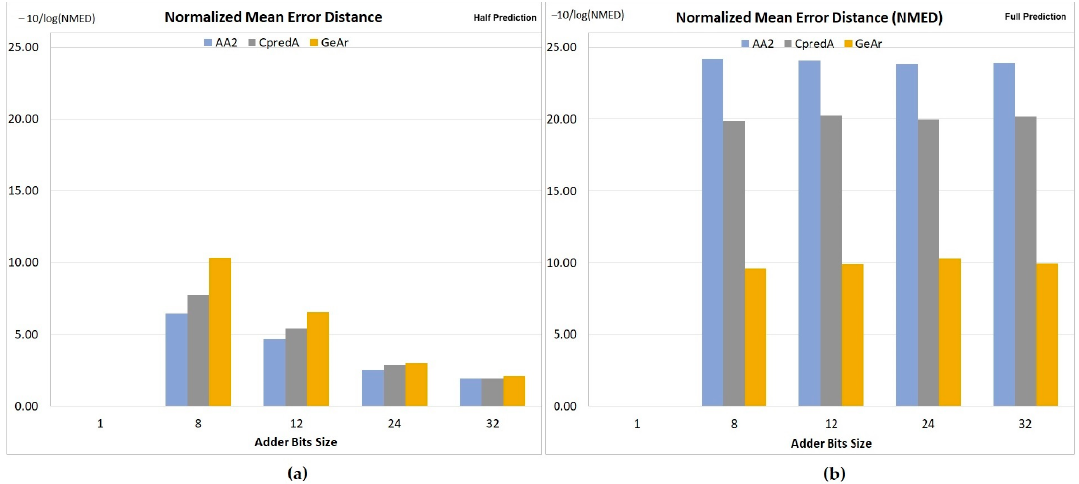
Figure 12. NMED of adders in ( a ) half prediction, ( b ) full prediction configurations.